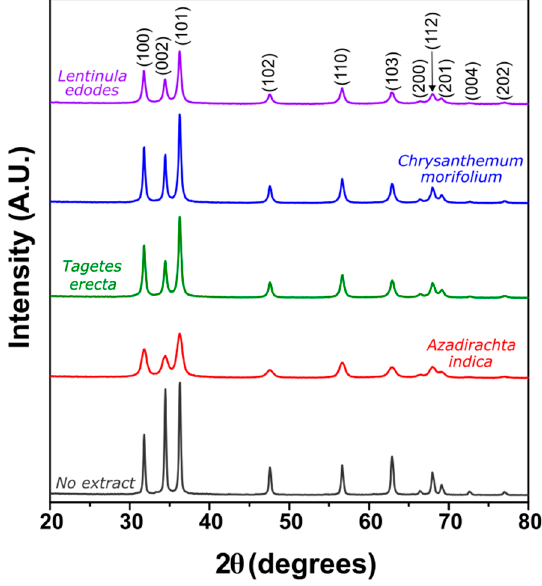
Figure 5. XRD patterns of ZnO NPs synthesized with different botanical extracts.